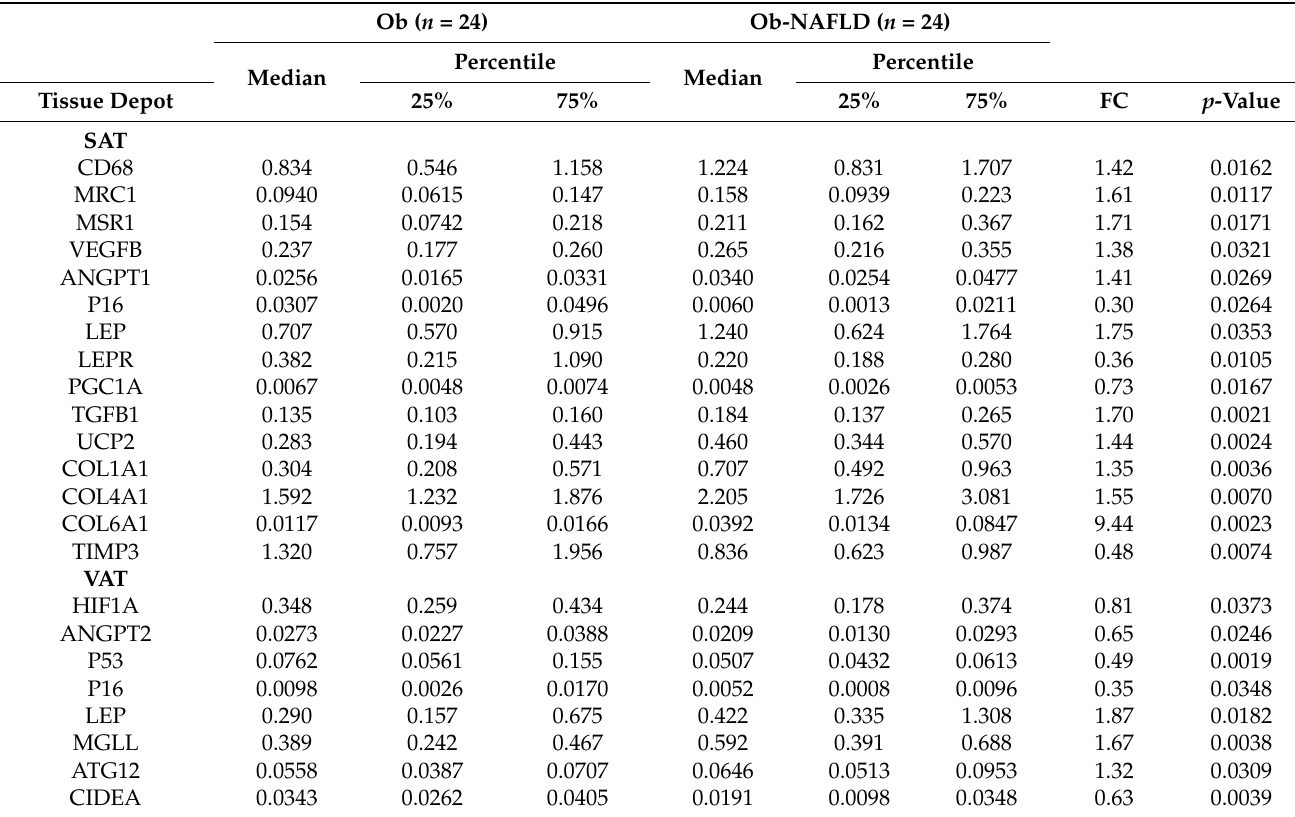
Table 3. Significant results of differential gene expression analysis in SAT and VAT from Ob-NAFLD vs. Ob